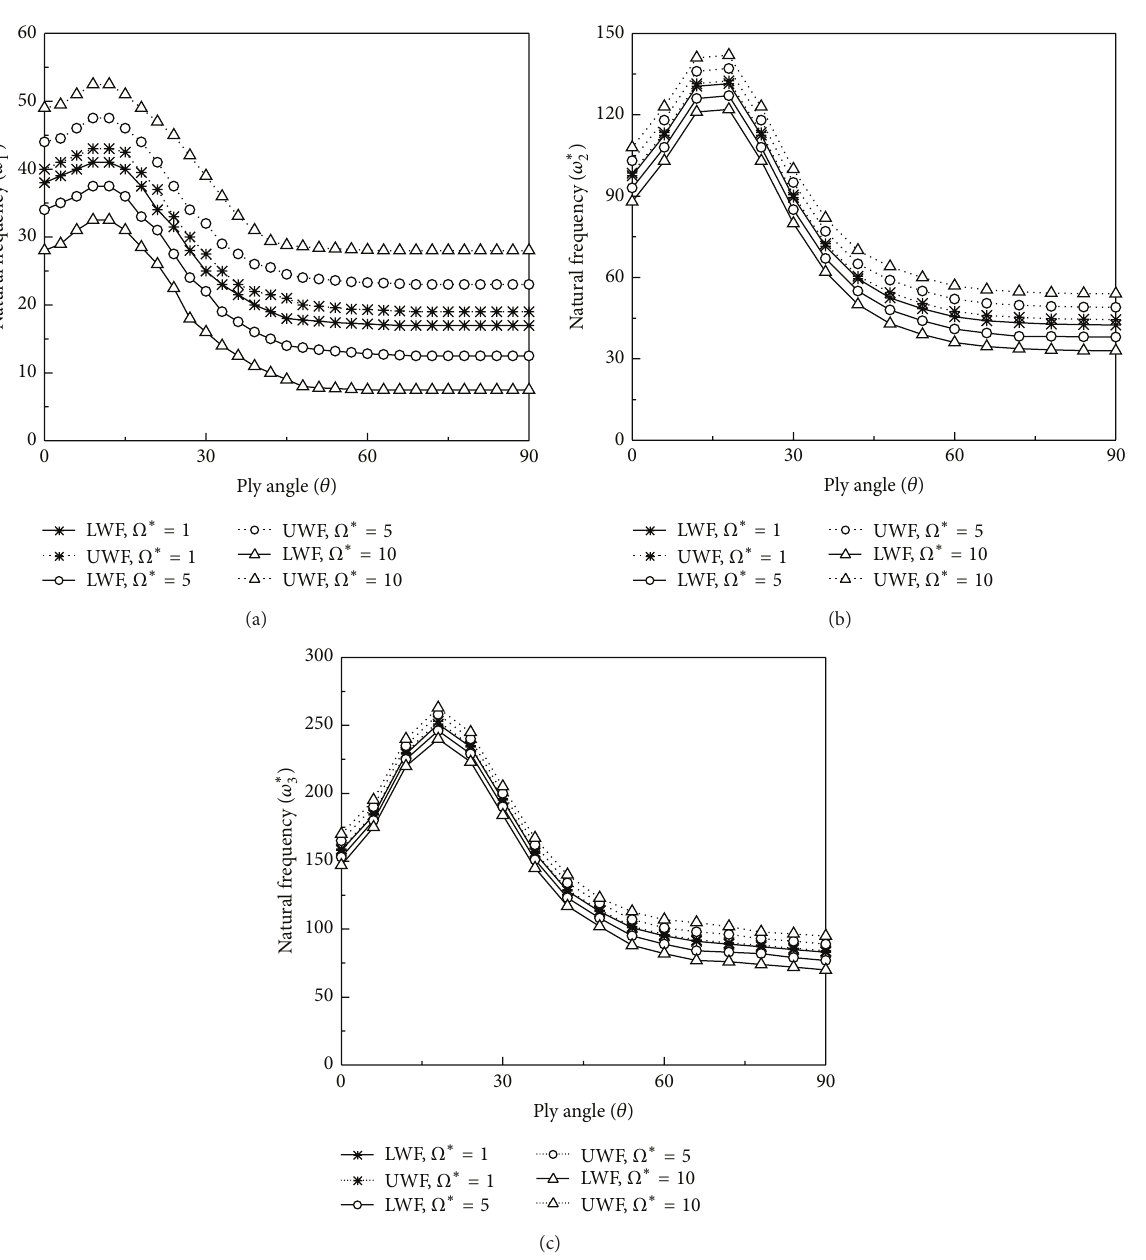
of SMA wire ( Ω ∗ = 5 rad/s; 𝑇 = 50 ∘ C; 𝑉 𝑠 = 0.36